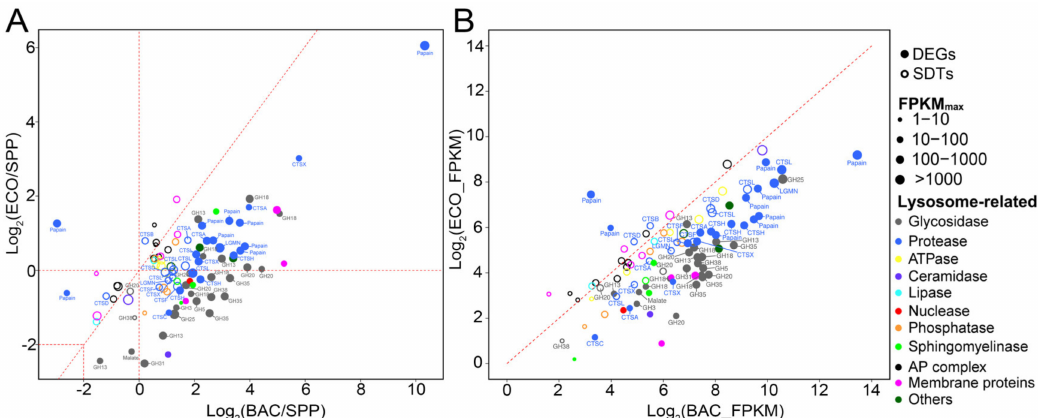
Figure 5. Relative expression levels of di ff erentially expressed genes (DEGs, solid circles; | log 2 (fold change) | ≥ 2) and significantly di ff erentiated transcripts with relatively lower fold changes (SDTs, open circles; 0 < | log 2 (fold change) | < 2) of T. thermophila associated with lysosomes in the pairwise comparisons between two bacterial treatment (BAC and ECO) and SPP ( A ), and BAC vs. ECO ( B ). Each dot represents an individual gene, and sizes of dots indicate expression abundance. Abbreviations: CTS, cathepsin; LGMN, legumain; Papain, papain family cysteine protease; GH, glycoside